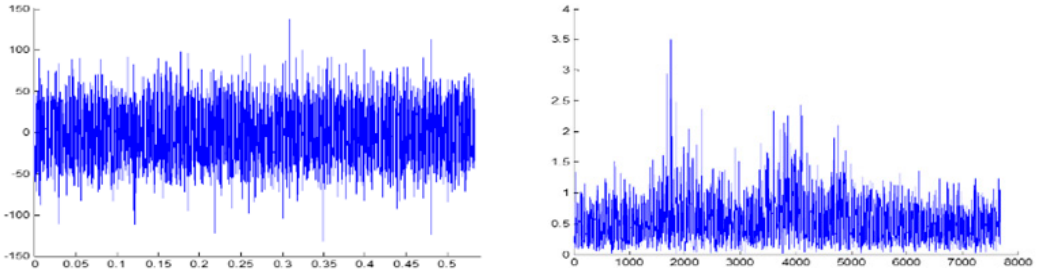
Figure 13. The bearing with compound fault.